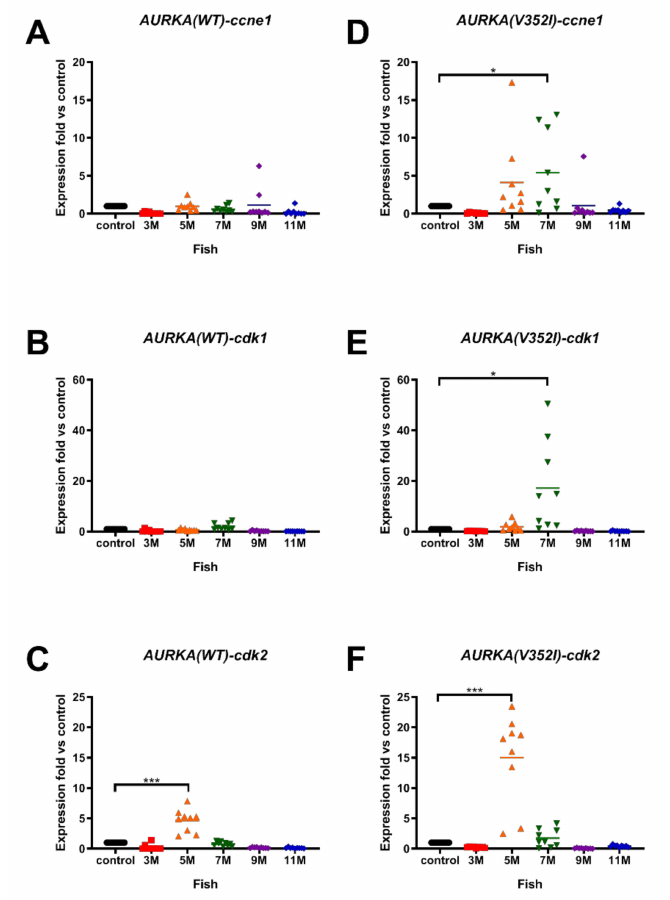
Figure 5. Expression of cell cycle related genes (cycle-related genes / proliferation marker genes G1 / S-specific cyclin-E1 ( ccne1 ), cyclin-dependent kinase 1 ( cdk1 ), cyclin-dependent kinase 2 ( cdk2 )) was higher in AURKA(V352I) than AURKA(WT) transgenic fish. qPCR analysis of cell cycle / proliferation markers ( A , D ) ccne1 ; ( B , E ) cdk1 ; ( C , F ) cdk2 in AURKA(WT) ( A – C ) and AURKA(V352I) ( D – F ) transgenic zebrafish compared to control fish at di ff erent time points. Expression fold compared to control fish (Tg(fabp10a:EGFP-mCherry) is shown in red (3 M), orange (5 M), green (7 M), purple (9 M), and blue (11 M). Statistical analysis of results was performed using a two-tailed Student’s t -test. Asterisks (*) represent the level of significance. * p -value ≤ 0.05; *** p -value ≤